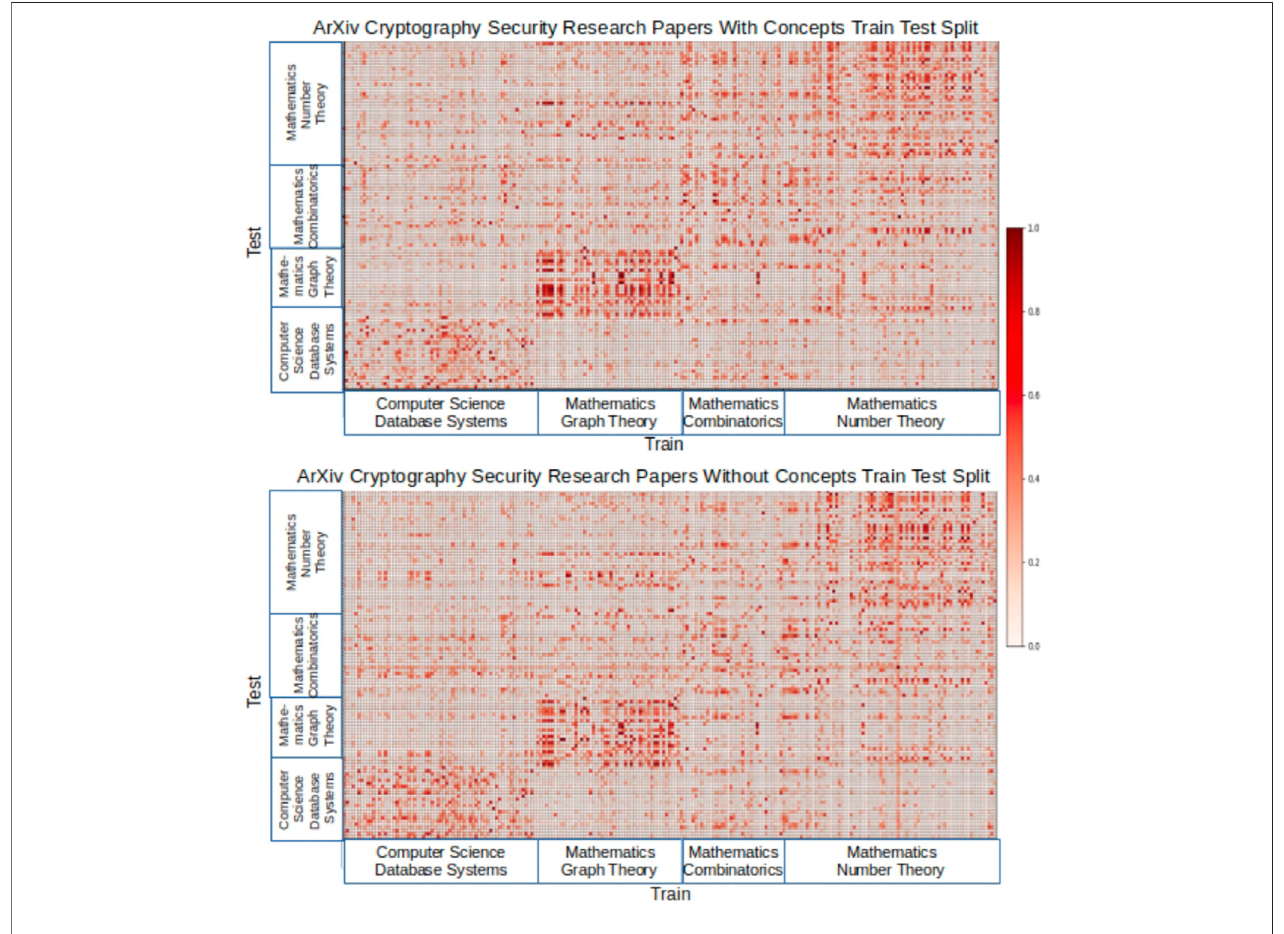
FIGURE 5 | arXiv train/test split heat maps.